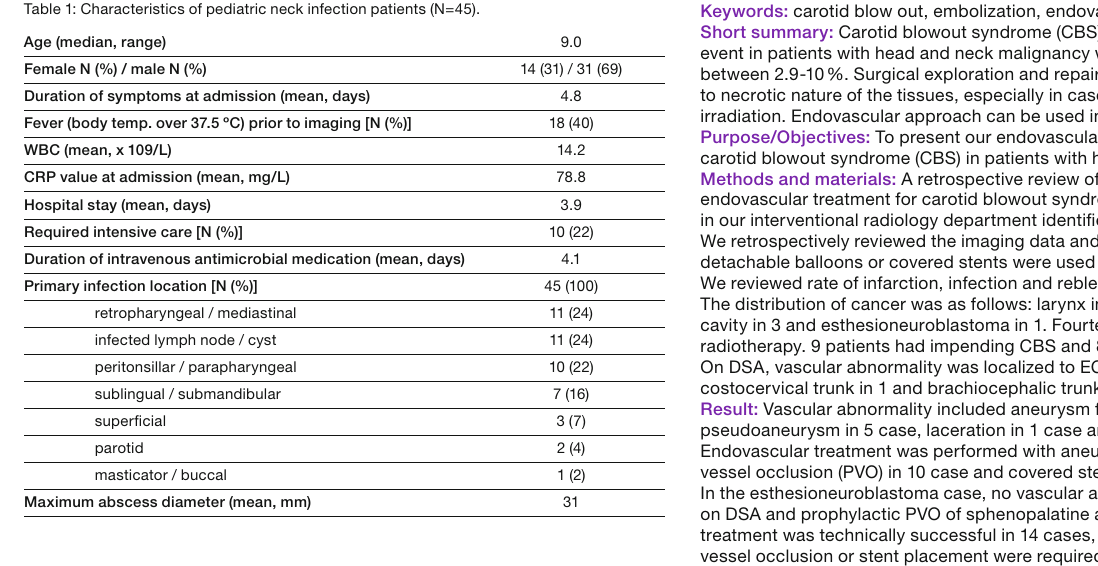
Table 2: Diagnostic accuracy of MRI in neck abscesses in pediatric and adult patients using surgery report as reference standard. TP FN FP TN